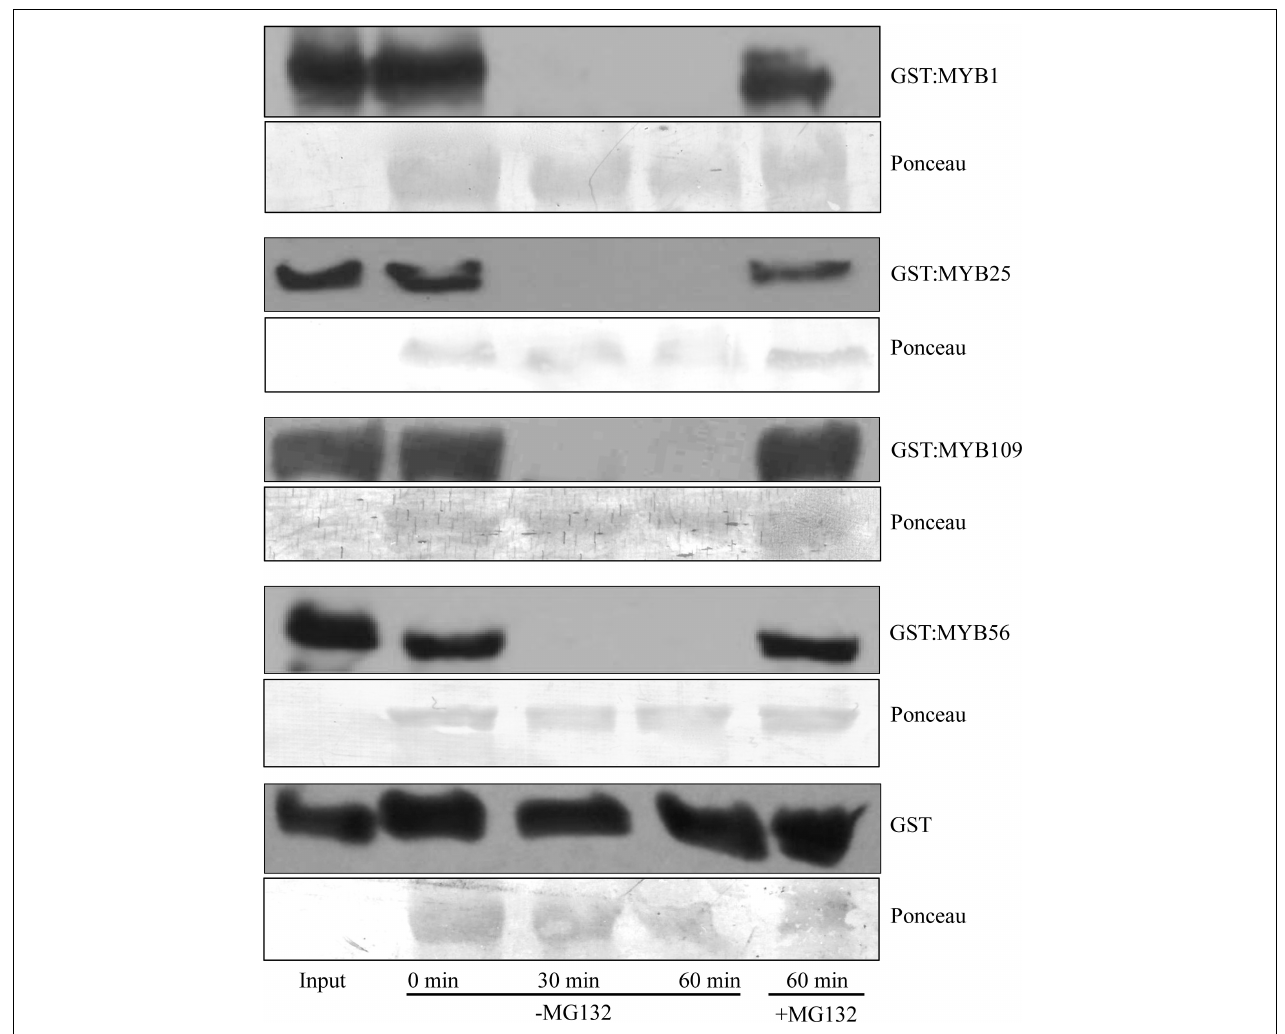
FIGURE 3 | Cell-free degradation assays show 26S proteasome-dependent instability of the S23 subfamily. Purified GST:MYB1, :MYB25, and :MYB109 proteins become fully degraded in cell-free degradation assays within 30 min. MG132, a proteasomal inhibitor, stabilizes the MYB proteins, demonstrating that their degradation requires activity of the 26S proteasome. GST was used as a negative control and remained stable throughout the incubation period of up to 60 min. Ponceau staining was used as loading control. The visible bands shown correlate in size with the large subunit of Rubisco ( ∼ 55 kDa).